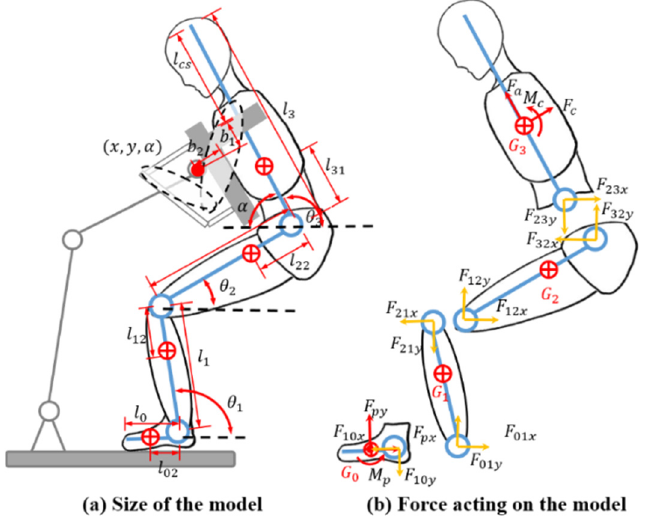
Figure 5. The size and forces of the model: ( a ) size of the model; ( b ) force acting on the model.